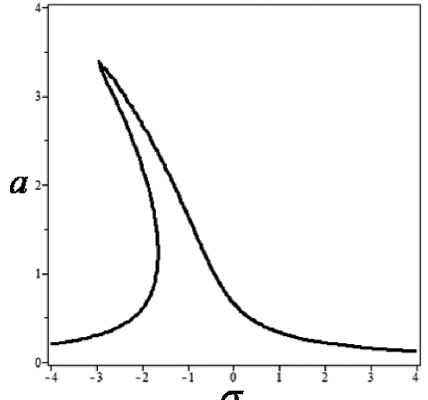
Fig. 4. The amplitude-frequency response curve near primary res- onance. D = 0.2 m, ω = 200 rad/s, γ m = 1000 T 2 m/H, ρ s = 7800 kg/m 3 , E = 206 GPa, C = 0.0002 m, C e = 0.0002 m, L = 3 m, L b = 0.05 m, e ¯ m = 0 . 0001 m, x a = 0.08, x b = 0.92, μ o = 0.018 Pa · s.